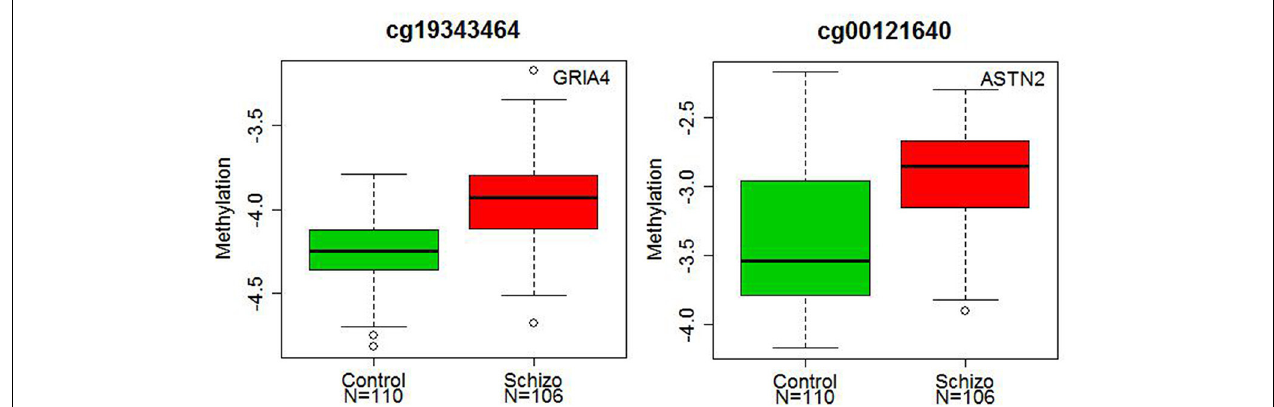
FIGURE 2 | Diagnostic differences in the DNA methylation levels of GRIA4 and ASTN2 . The x axis represents diagnostic groups (control and schizophrenia), and the y axis represents DNA methylation levels (log2 ratio of methylated and unmethylated probe intensities). The lines in the bar graph indicate the median, and the bars (whiskers)